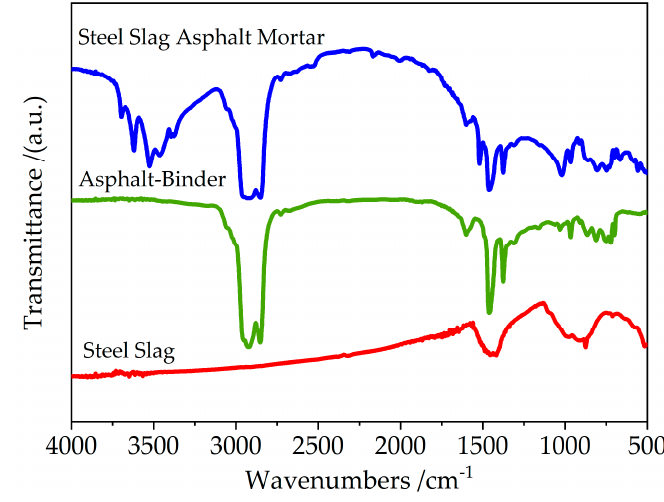
Figure 5. Infrared spectra of the asphalt-binder, steel slag, and mortar.